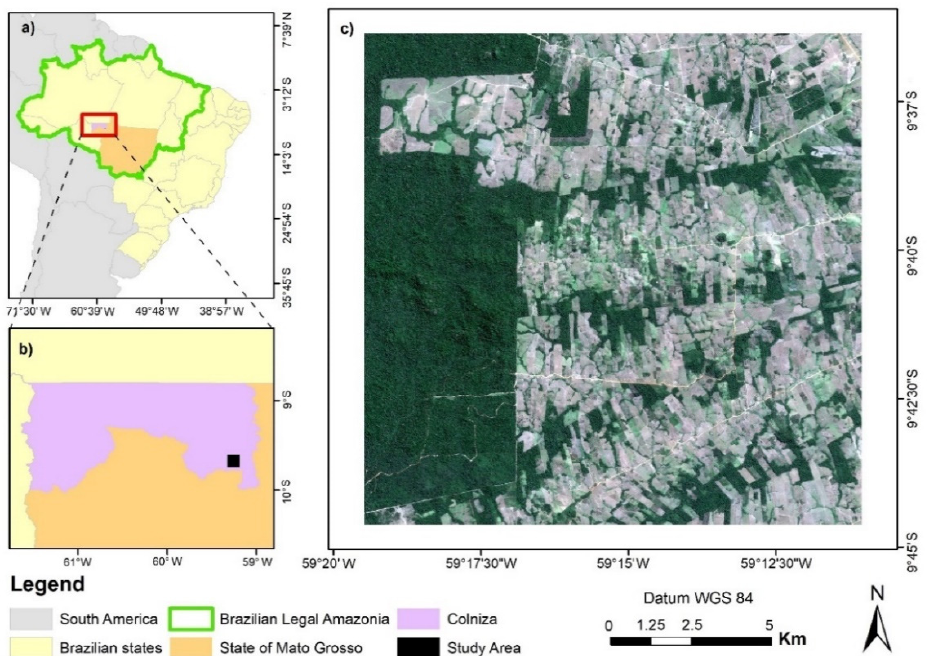
Figure 1. Location of the study area in the Brazilian Legal Amazon ( a ) and in the municipality of Colniza, Mato Grosso State ( b ). Study area over a Sentinel-2 true color composition image from 27 July 2018 ( c ).